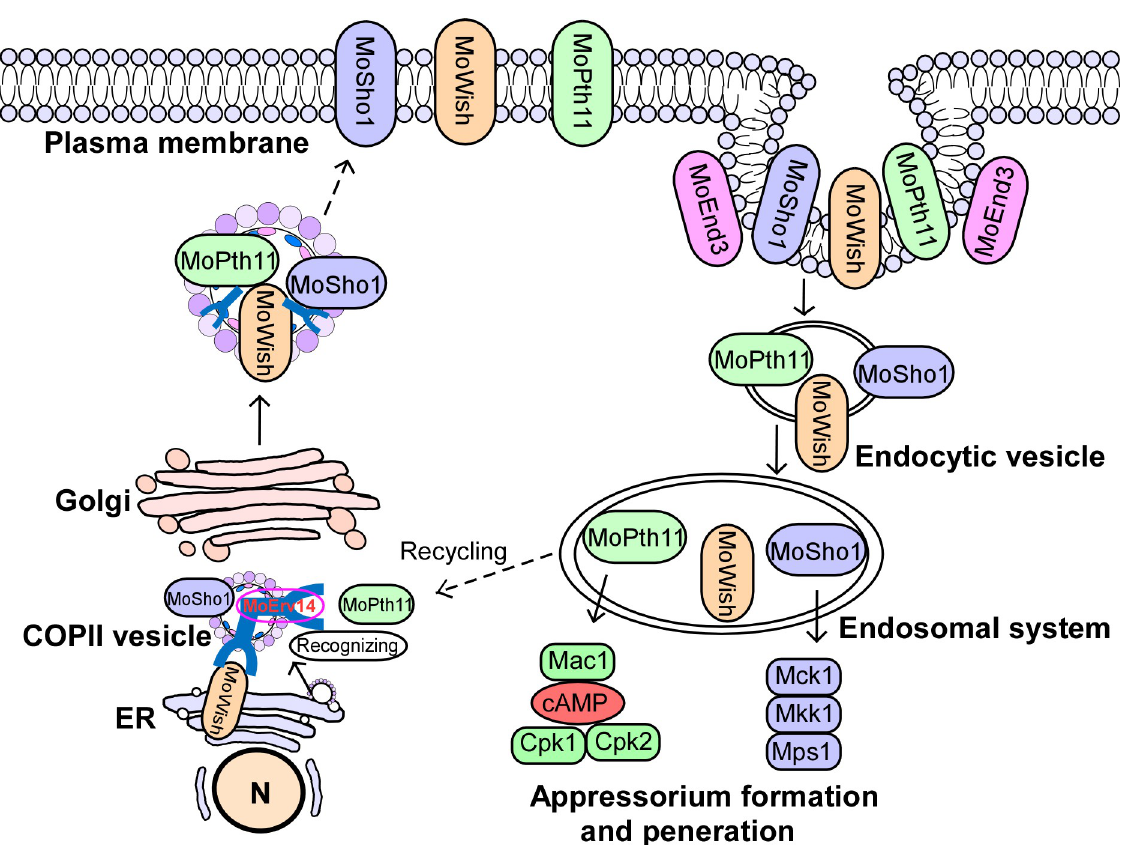
Fig 9. A proposed working model of MoErv14 function. During germ tube development, GPCR Pth11, Wish, and membrane sensor MoSho1 are recognized and transported by MoErv14. After seining the plant surface signals the membrane sensors are regulated by MoEnd3-mediated endocytosis. Following transport to endosomal systems by endocytic vesicles, MoPth11, MoWish, and MoSho1 can trigger a downstream Pmk1-MAPK and CWI MAPK cascade. The MAPK cascade facilitates successful appressorium formation, penetration, and